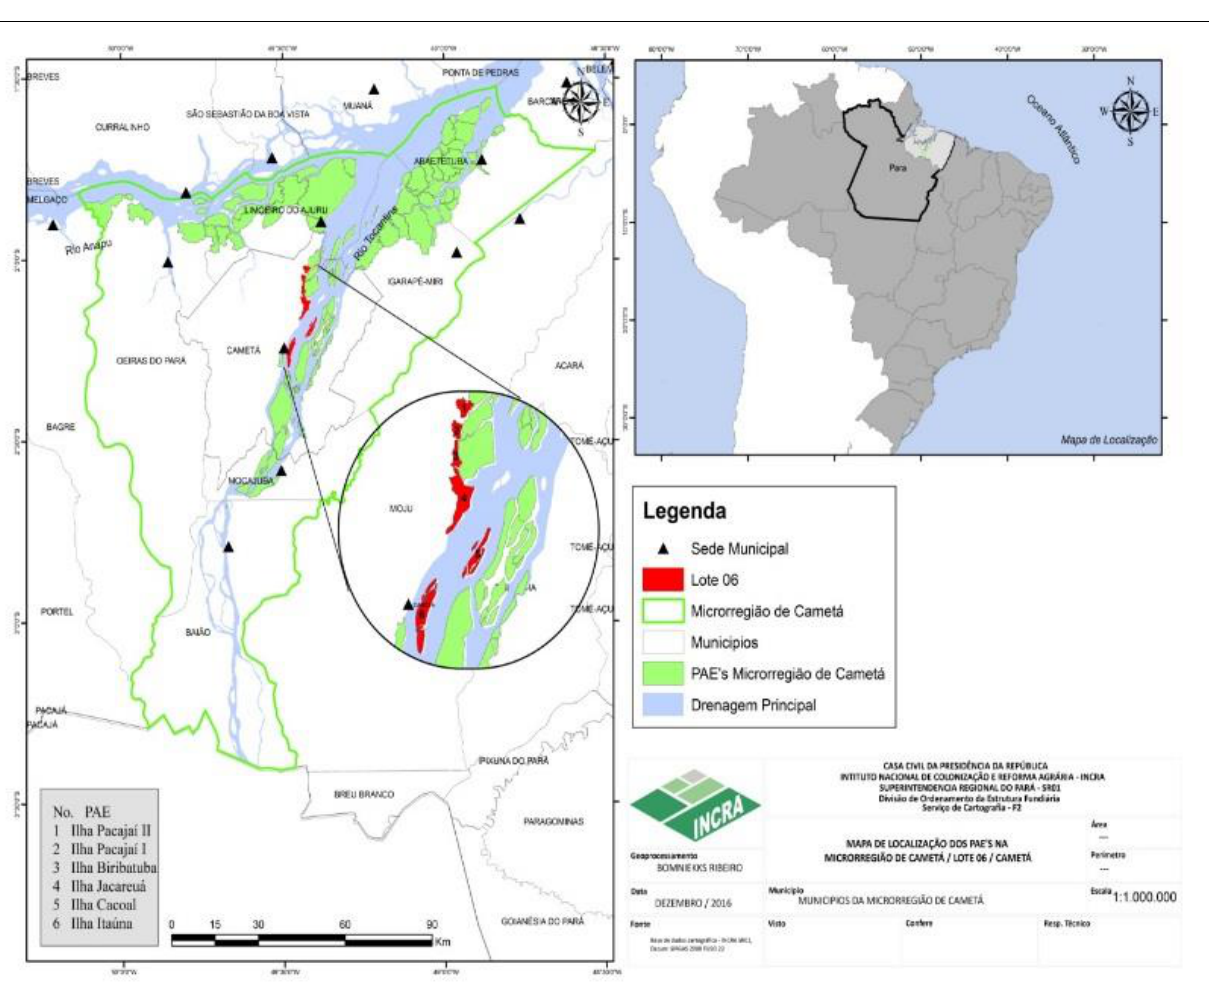
Figura 1: Mapa de Localização dos PAE´s na Microrregião de